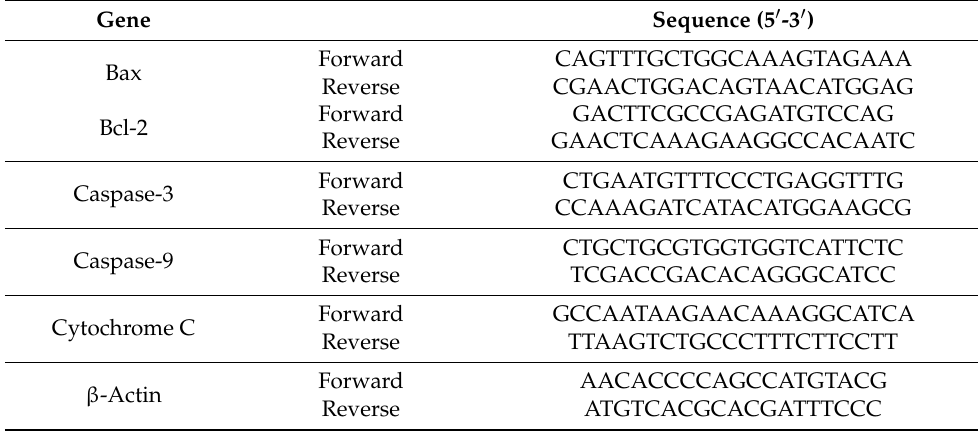
Table 1. Primer sequences used in the real-time PCR assay. Gene Sequence (5 (cid:48) -3 (cid:48) ) Forward Bax